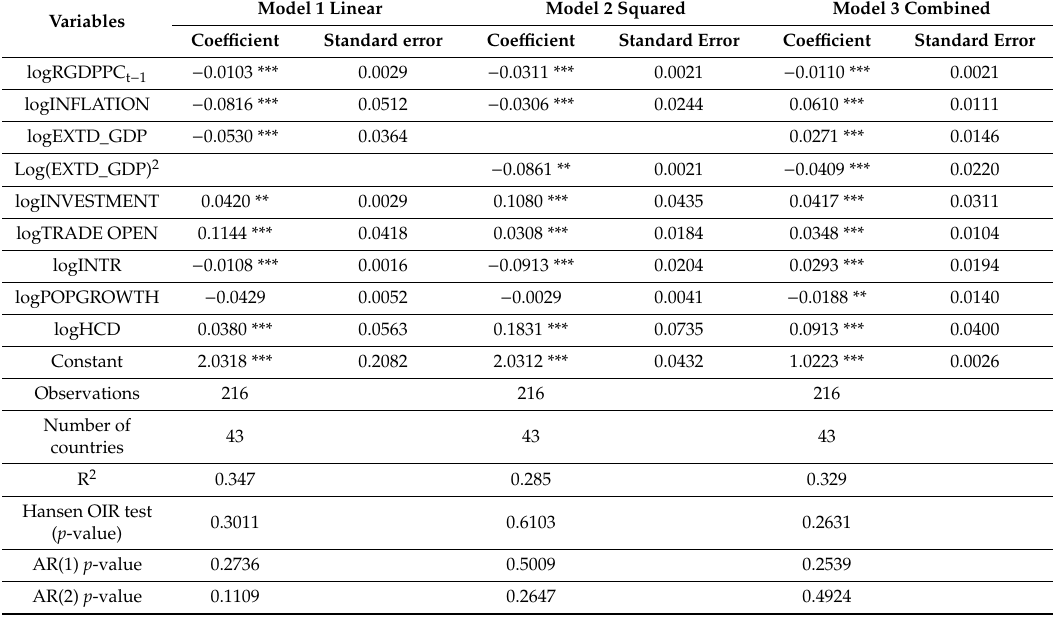
Table 6. Results of the System GMM